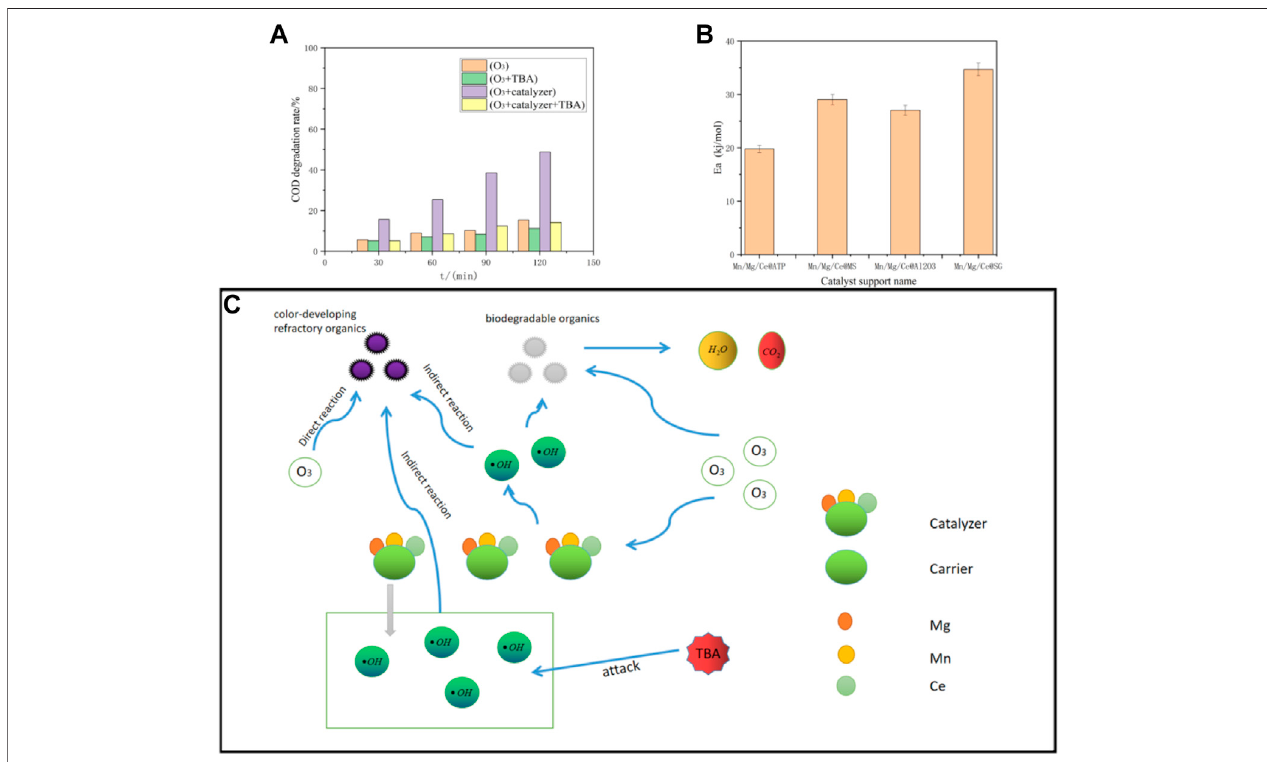
FIGURE3| (A) Histogram experiment dataofradical quenching experiment inred powderwastewater. (B) Graph ofactivationenergyoffour supported catalysts. (C) Mechanism diagram of ozone catalytic oxidation.